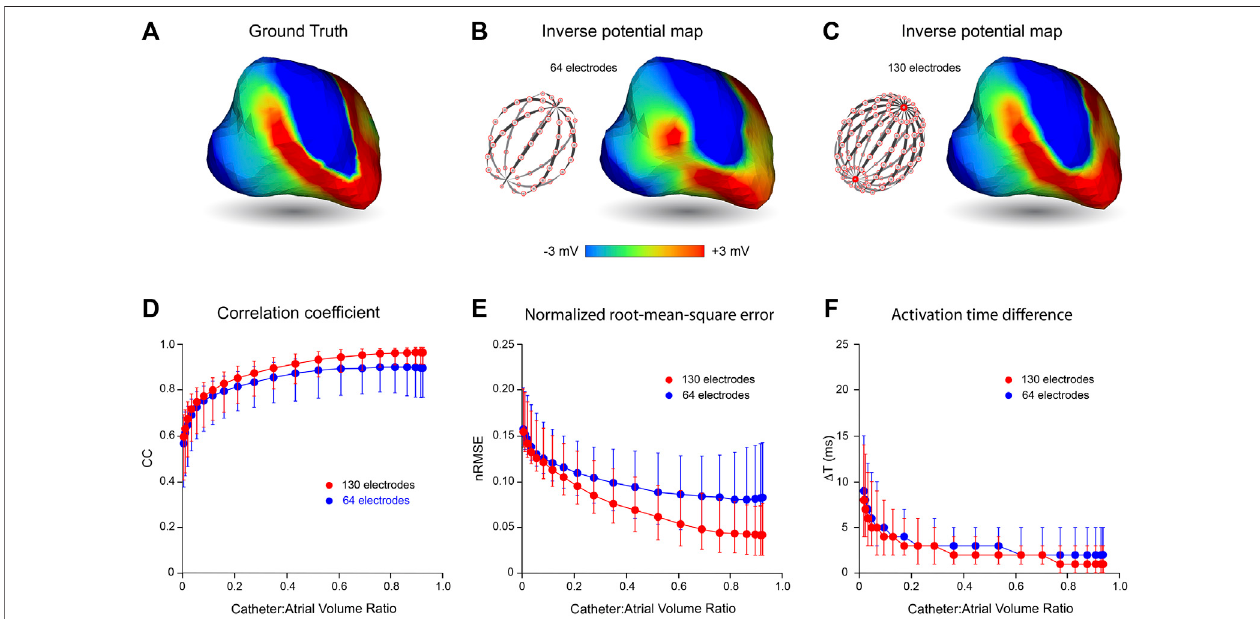
FIGURE 3 | Effects of mapping catheter electrode distribution on inverse solutions with MFS during macro reentry. LA surface potentials throughout 3 activation cycles in simulated atrial fl utter are reconstructed from electrograms sampled inside the LA cavity with 64- and 130-electrode basket catheters and compared with ground-truth surface potentials. The upper panel presents typical results for catheters that bound a volume fraction of 0.67 relative to LA volume. These include (A) the ground-truth surface potential distribution at one instant during reentrant activation and corresponding potential maps reconstructed using electrograms sampled with (B) a64-electrodebasketcatheter,and (C) a130-electrodebasketcatheter.InthelowerpanelCC (D) ,nRMSE (E) and Δ T (F) arepresentedasfunctionsofrelative catheter volume for the 64-electrode catheter (blue) and 130-electrode catheter (red). Median values and IQR are given. Abbreviations: MFS, Method of Fundamental Solutions; LA, left atrium; CC, correlation coef fi cient; nRMSE, normalized root-mean-squared error; Δ T, activation time difference; IQR, interquartile range.